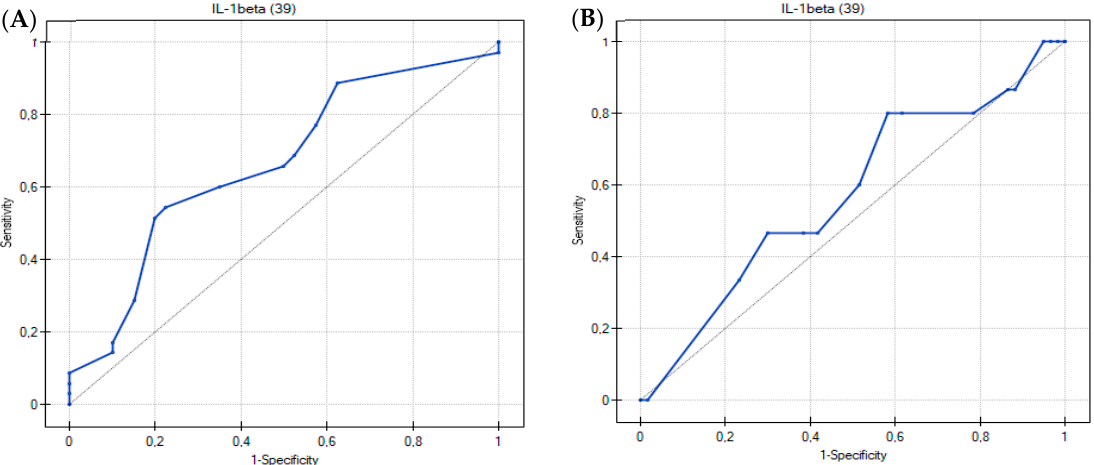
Figure 5. Univariate receiver operating characteristic (ROC) curve shows the correlation between the serum concentration of IL-1 beta ( A ) in patients with IgE-mediated allergy and other participants; ( B ) in patients with delayed-type food allergy and other participants.